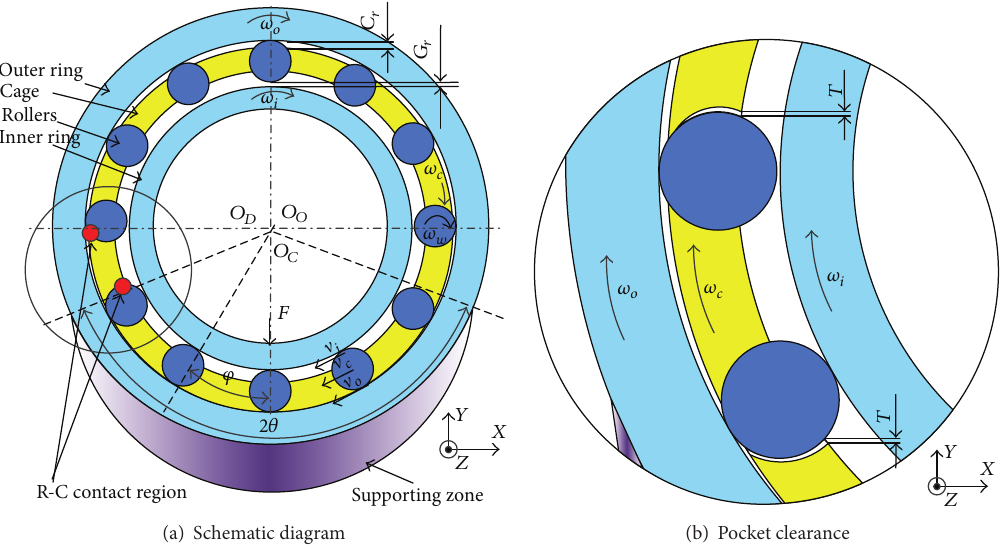
Figure 2: Schematic diagram and pocket clearance in a cylindrical roller